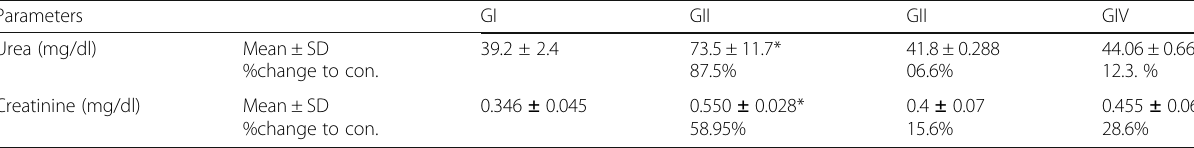
Table 4 Effects of olive leaf extract (OLE) and/or STZ administration on some biochemical parameters on pregnant mice serum Parameters